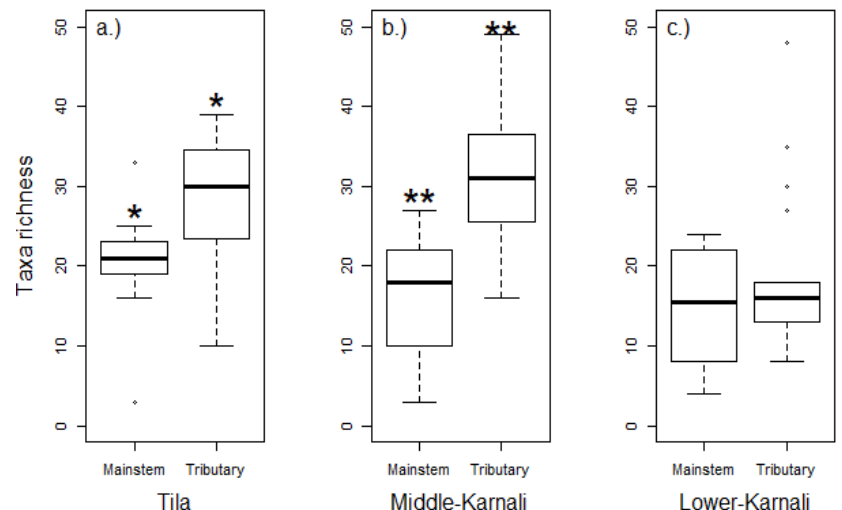
Figure 2. Benthic macroinvertebrate taxa richness differences between the river’s mainstem and the tributaries in the three selected watersheds ( a . Tila, b . Middle-Karnali, c . Lower-Karnali ) of the Karnali River Basin. Each boxplot shows the median value (black line), the 25th and 75th percentiles (rectangle edges), the min and max values (vertical lines) and the outliers (white circles). *Differences are significant at the p < 0.05 level. **Differences are significant at the p < 0.01 level.